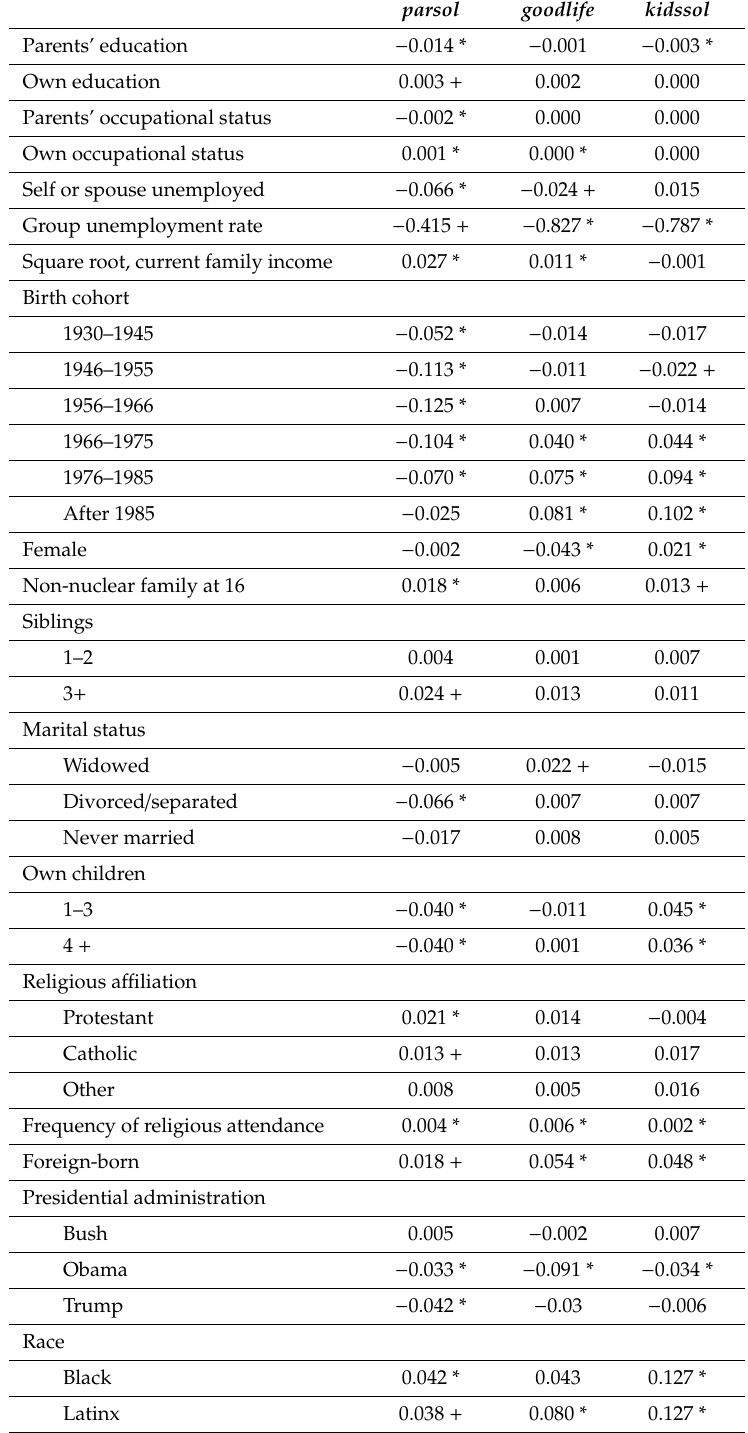
Table 2. Models predicting perceived